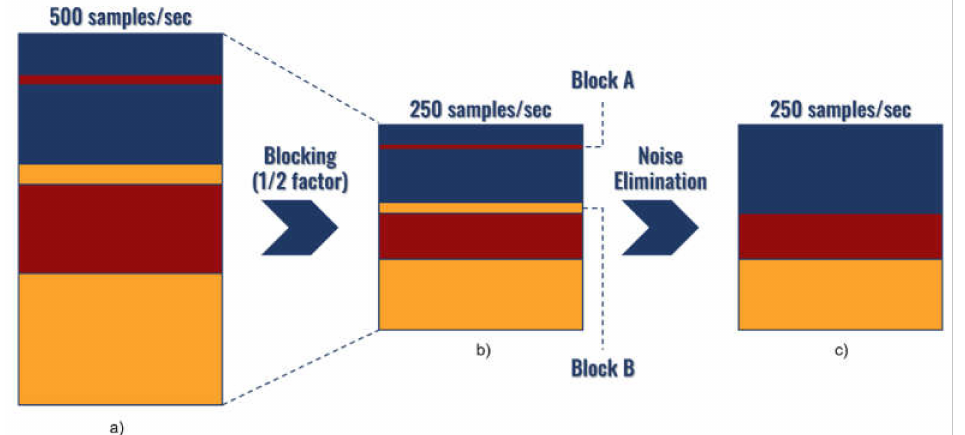
Figure 7. Pre-association steps: ( a ) original clustering considering samples of 2 ms, ( b ) result of the blocking process with a factor of 1/2 (each element of the column represents 4 ms on the original domain), ( c ) result of the noise elimination (eliminates the smaller red and orange sets that presented size of 4 and 8 ms, respectively). Above the columns, the correspodent sampling frequency is